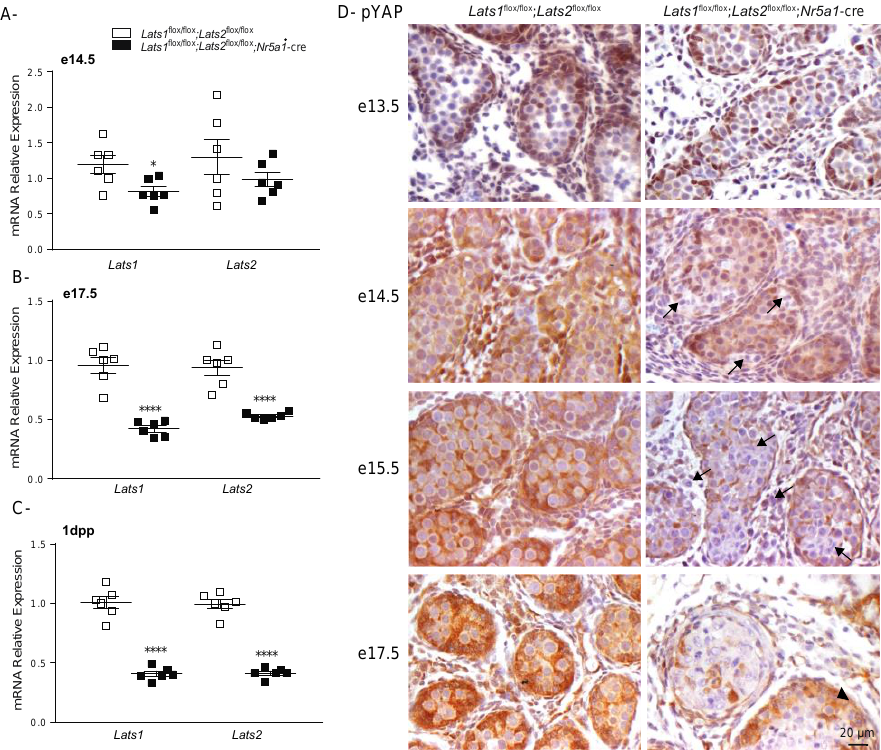
Figure 3. Efficiency of Lats1 and Lats2 knockdown in the testes of Lats1 flox/flox ; Lats2 flox/flox ; Nr5a1 -cre mice. ( A – C ) RT-qPCR analysis of Lats1 and Lats2 mRNA levels in the testes of ( A ) e14.5, ( B ) e17.5, and ( C ) 1 dpp mice of the indicated genotypes ( n = 6 animals/genotype). All data were normalized to the housekeeping gene Rpl19 and are expressed as means (columns) ± SEM (error bars). Asterisks = significantly different from control (* p < 0.05; **** p < 0.0001). ( D ) Immunohistochemical analysis of phospho-YAP expression in the testes of mice of the indicated genotypes. Scale bar (lower right) is valid for all images. Arrowhead = cells with inefficient recombination. Arrow = cells with efficient recombination.